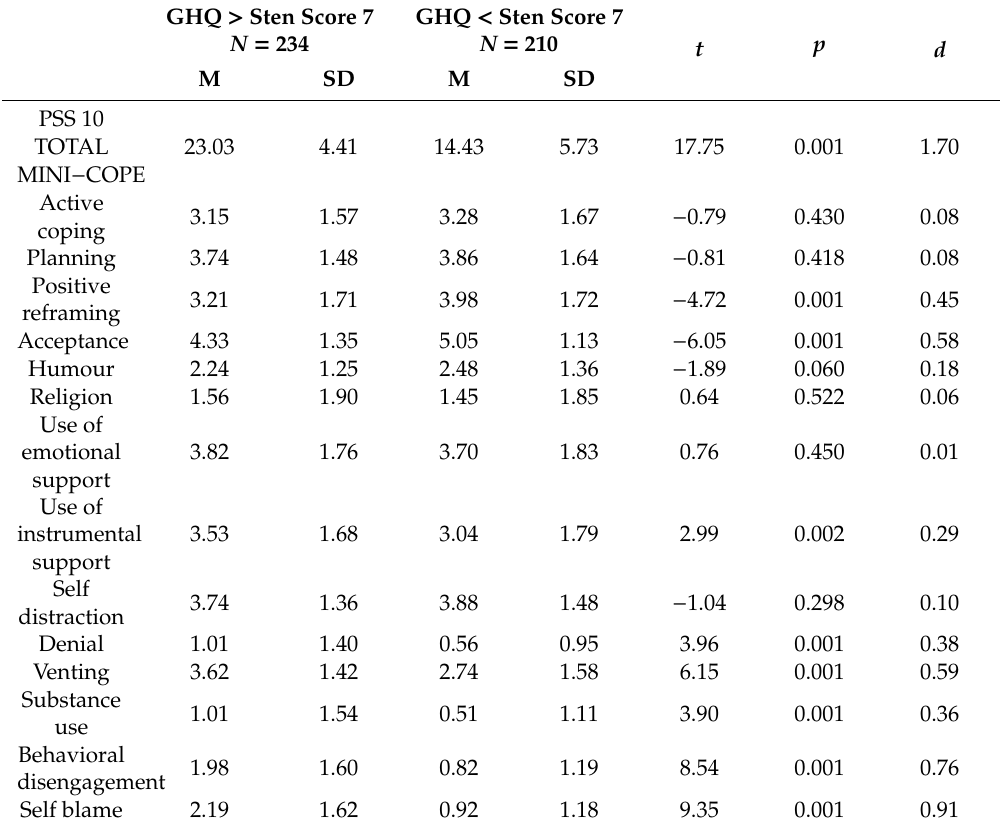
Table 5. Comparison of PSS 10 and MINI-COPE results among the respondents with high and low scores in the GHQ-28 questionnaire. GHQ > Sten Score 7 GHQ < Sten Score